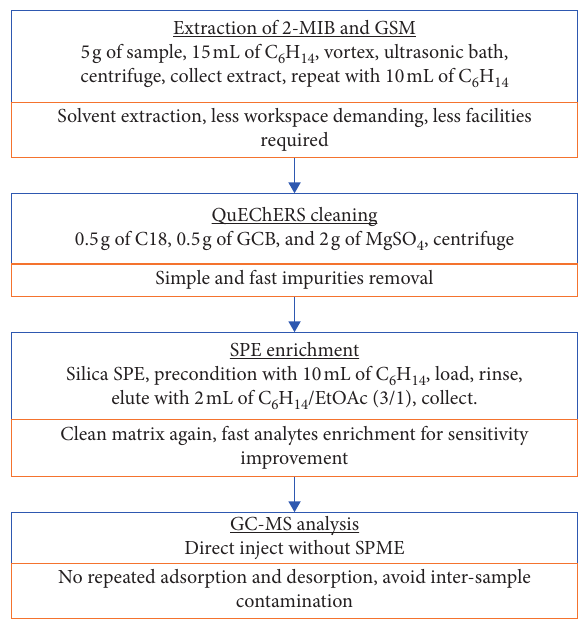
Figure 1: Workflow for analysis of 2-MIB and GSM residues in the fish